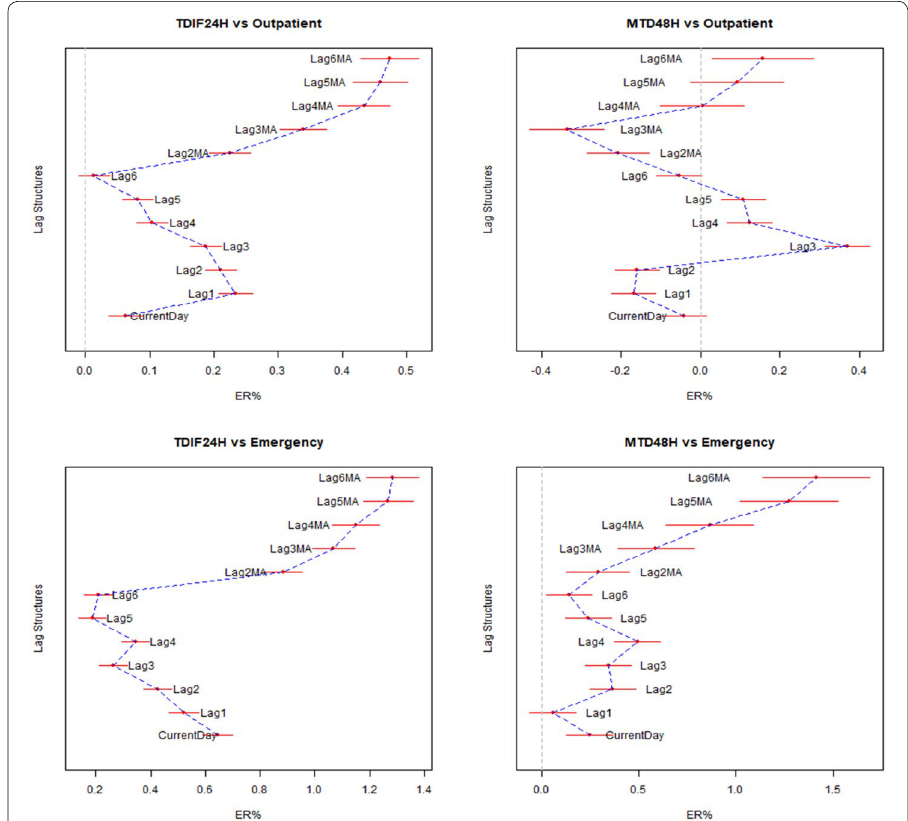
Fig. 5 Percent increase (excess risk, ER) with different lag structures for total pediatric outpatient and emergency admissions (three hospitals) owing to temperature change. ER for 1 °C increases in temperature difference in 24 h (TDIF24H) and absolute value of mean temperature difference in 48 h (MTD48H). ER values obtained by single‑pollutant regression. The X‑axis represents ER values, and the Y‑axis is the different lag structures. Red bars indicate 95% confidence intervals of ER. Lag1 to Lag6 are simple lag effects and Lag2MA to Lag6MA are 2‑day to 6‑day cumulative